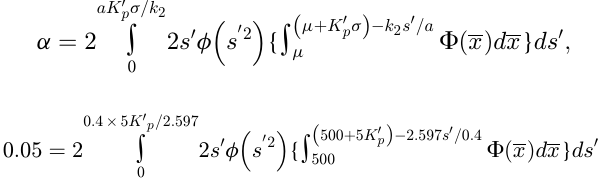
Table 7. AQLs corresponding to k Sample size